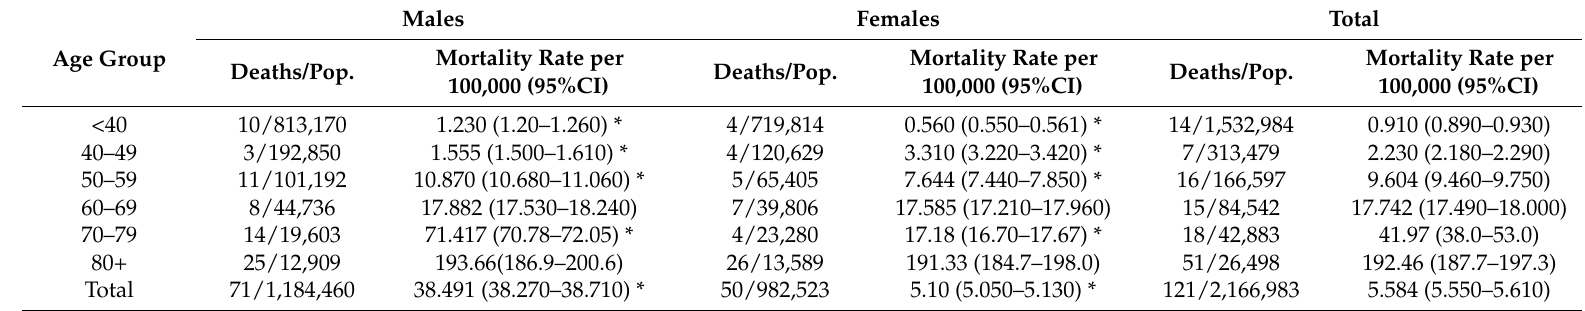
Table 2. In-hospital first-time stroke Mortality rate (per100,000 populations) and concomitant 95% Confidence Intervals (95% CI) by age groups and